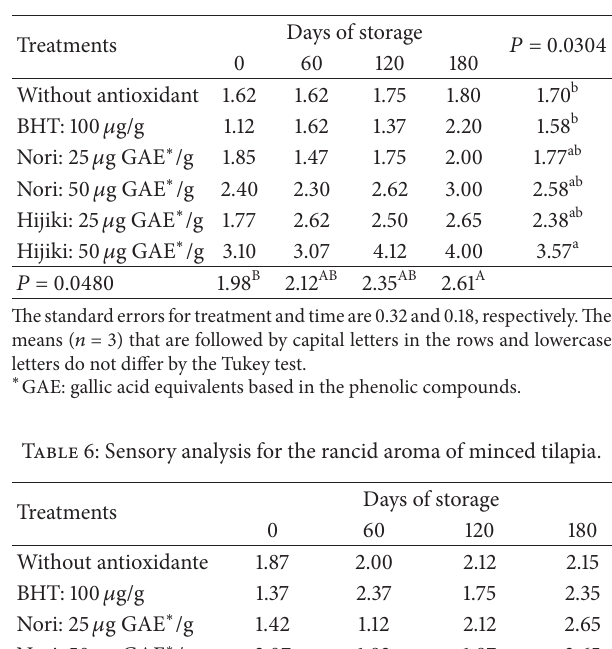
Table 5: Sensory analysis for the color of minced tilapia.